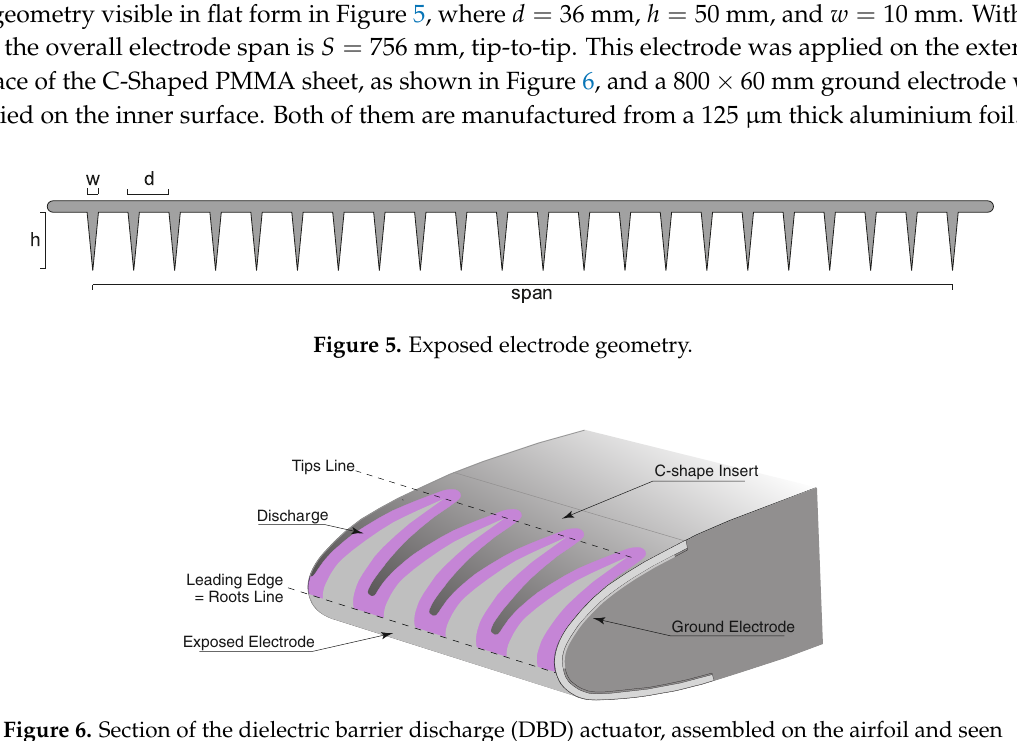
Figure 6. Section of the dielectric barrier discharge (DBD) actuator, assembled on the airfoil and seen from below of Figure 2: The discharge is sketched as a color band around the contour of the exposed electrode. At maximum voltage, the discharge fills almost completely the spaces between